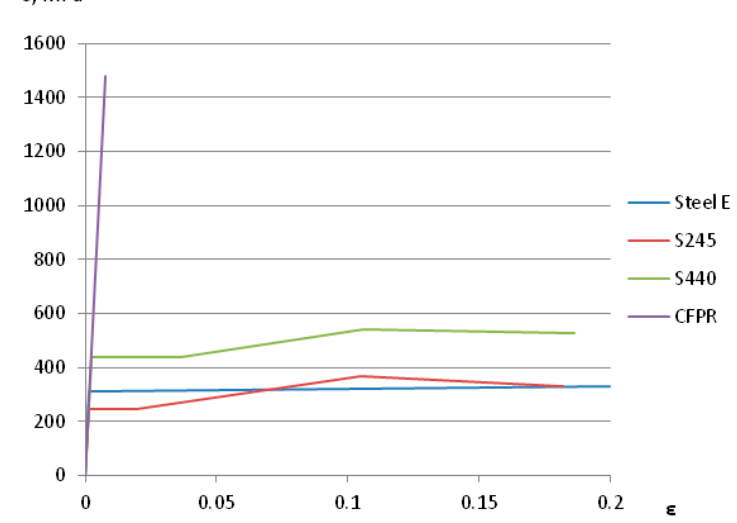
Figure 7. Strain-stress dependencies of the materials.